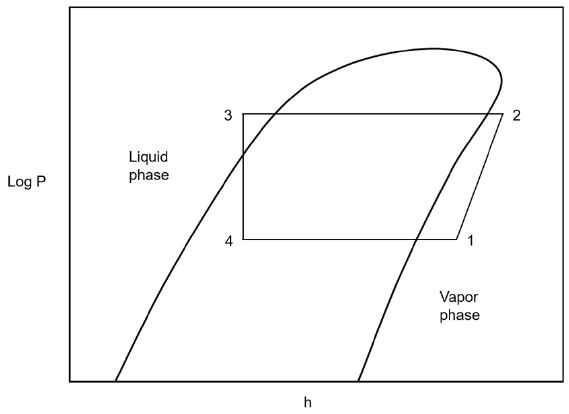
Figure 7. Thermodynamic cycle for the vapor compression of the new heat-pump-assisted conventional